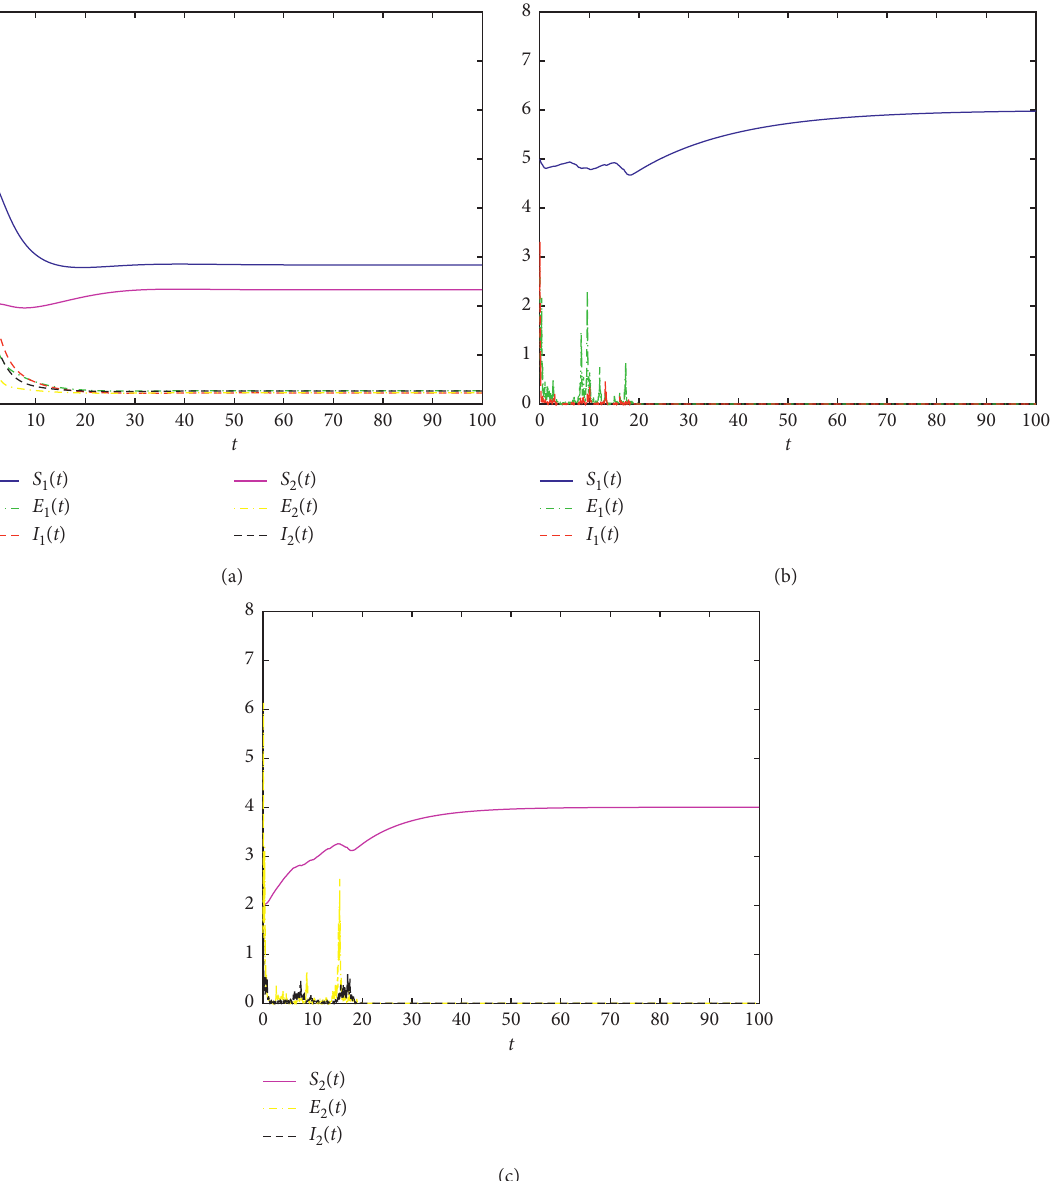
Figure 2: The trajectories with R > 1: (a) the trajectory without stochastic perturbation; (b, c) the trajectories with stochastic perturbations 0 where parameters are shown in Example